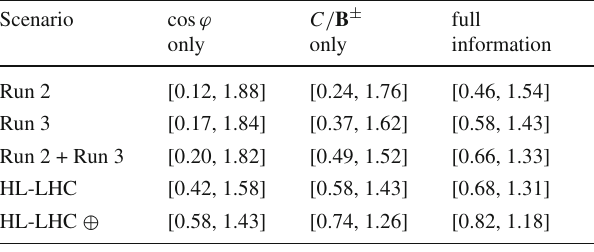
Table 2 90% credibility intervals on f SM , according to the various scenarios described in the text of Sect. 3.2. Here, “HL-LHC ⊕ " refers to the HL-LHC setup with improved systematic uncertainties